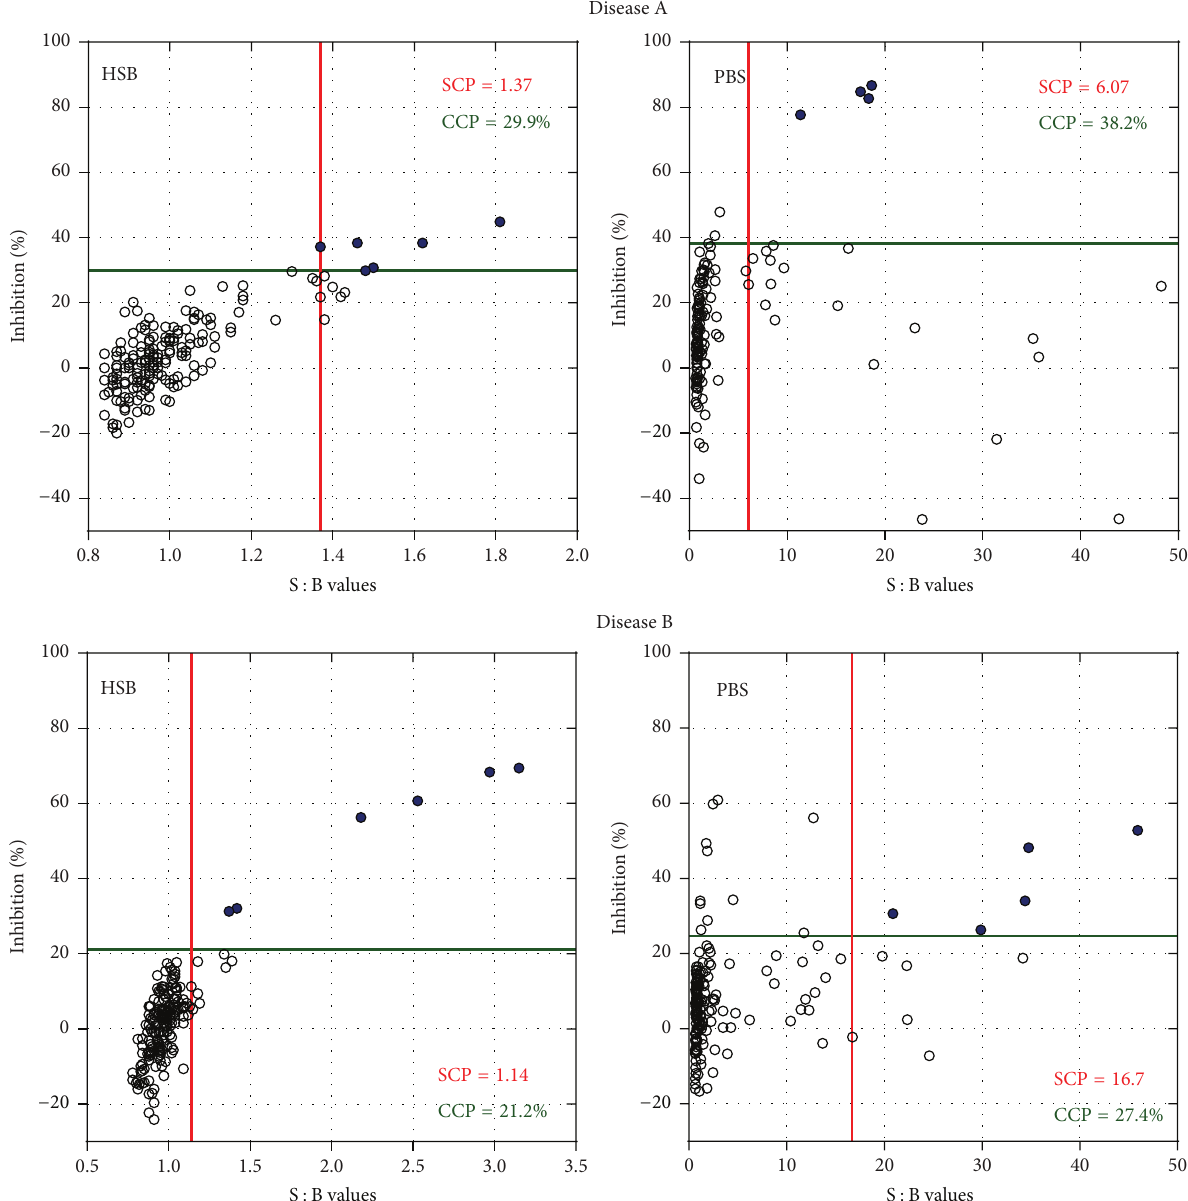
Figure 5: Screening and confirmatory responses of individual drug-na¨ıve disease A and disease B samples tested using conjugated reagents stored in HSB or in PBS. The vertical red and horizontal green lines on each graph show screening (SCP) and confirmatory cut points (CCP), respectively. Open circles ( I ) indicate negative responses and closed circles ( e ) correspond to confirmed